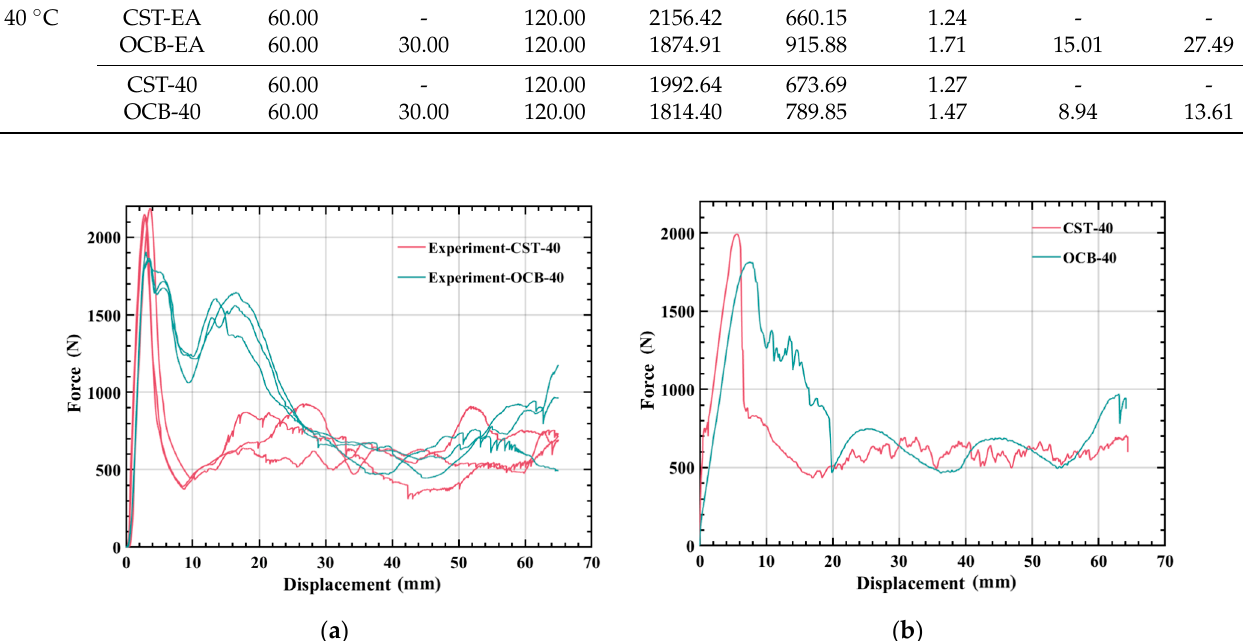
Figure 8. ( a ) Comparison of force-displacement curves of OCB and CST in experiment; ( b ) comparison of force-displacement curves of OCB and CST in numerical simulation. Table 3. Comparison of CST and OCB experimental and numerical simulation results.